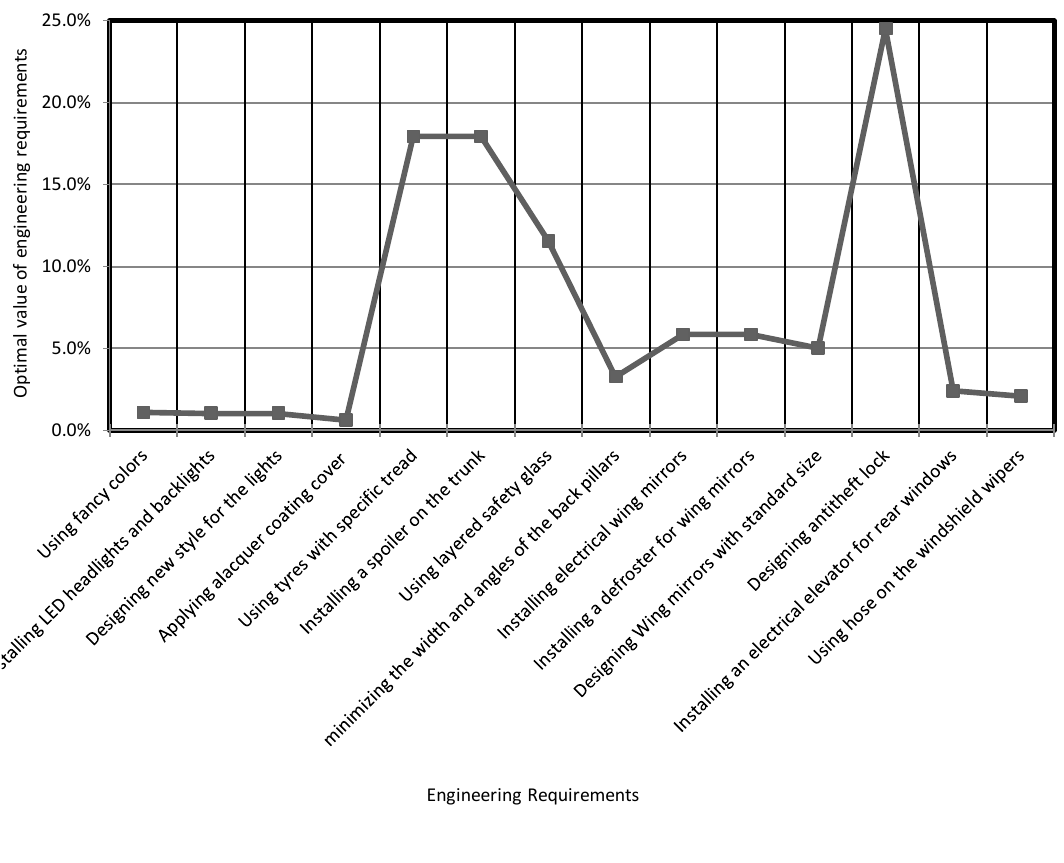
Figure 10. Optimal costs of the engineering